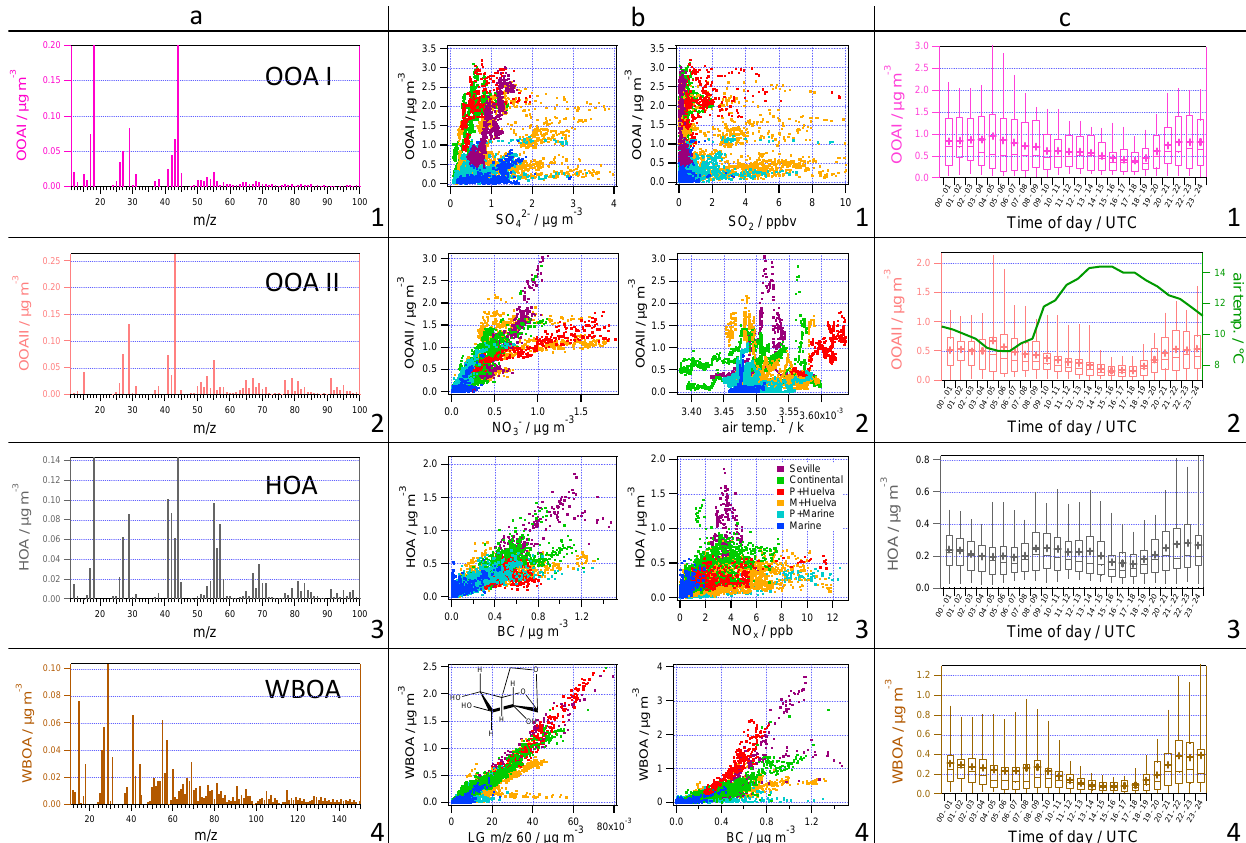
Fig. 9. Mass spectra (a) , correlations (b) and diurnal variation box plots (c) of OOA I (dark purple, 1), OOA II (salmon, 2), HOA (grey, 3) and WBOA (brown, 4) organic aerosol types. Mass spectral markers were compared to reference spectra (not shown). The four factors were correlated with aerosol species (sulfate, nitrate, m/z 60 as levoglucosan tracer, black carbon), trace gases (nitrogen oxide, sulfur dioxide) and meteorological parameters (air temperature) (b) . Box plots of the diurnal variation for the whole campaign (c) show the median, mean and the 25/75% percentiles. The whiskers indicate the 5/95% interquartile span. Points in the correlations (b) represent 2min average